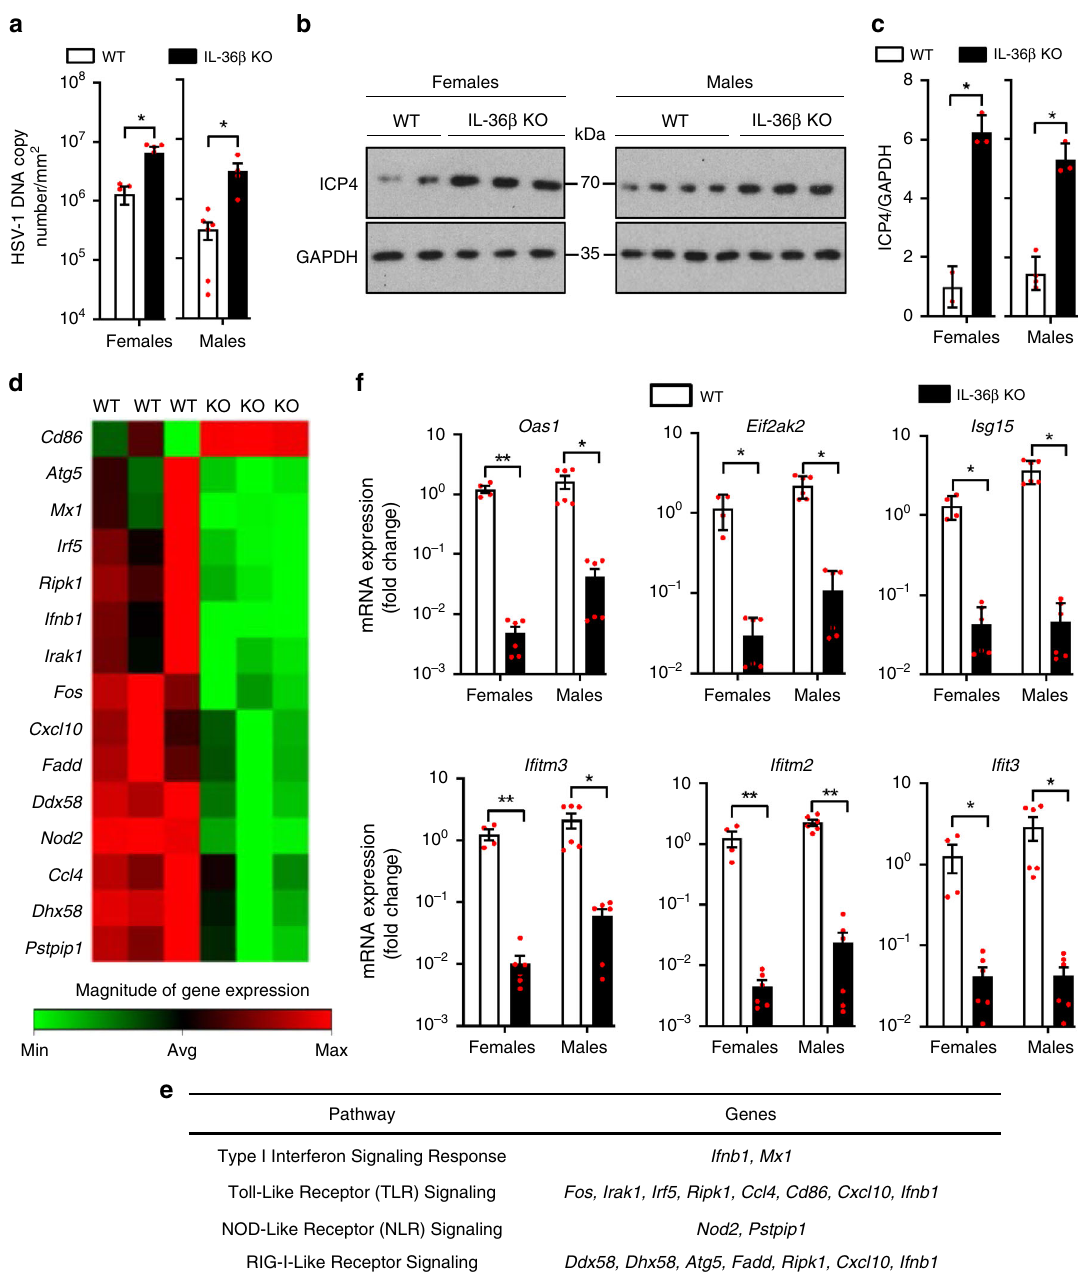
Fig. 1 IL-36 β KO mice exhibit altered responses to HSV-1 skin infection. a Wild type (WT; n = 5 ♀ and 13 ♂ ) and IL-36 β KO mice ( n = 7 ♀ and 12 ♂ ) were infected with HSV-1 on the fl ank and skin regions along HSV-1 infected dermatomes collected 6 days post-infection. Viral DNA loads were determined by QPCR. Data are pooled from three independent experiments and shown as means ( ± SD). * p < 0.05 (One-Way ANOVA). b , c Viral ICP4 protein levels were examined by Western blotting ( b ) and quanti fi ed using ImageJ software ( c ). GAPDH was used as loading control. Data are representative of three independent experiments and shown as means (±SD) in c (WT: n = 2 female and 4 male; IL-36 β KO mice: n = 3 female and 3 male). * p < 0.05 (one-way ANOVA). d Wild type and IL - 36 β KO mice were infected with HSV-1 ( n = 3 per group) on the fl ank and skin RNA isolated 6 days post-infection. Heat-map of genes differentially expressed in the two strains is shown. e Pathway associations of genes identi fi ed as differentially expressed in d . f Expression of Oas1, Eif2ak2, Isg15, I fi tm3, I fi tm2, and I fi t3 mRNAs were examined in wild type and IL-36 β KO HSV-1 infected skin ( a ). The mRNAs were normalized against GAPDH and are shown as relative expression compared to female wild-type mice (means ± SD). * p < 0.05; ** p < 0.005 (one-way ANOVA). Each red dot represents a single data point. Source data are provided as a Source Data fi Fig. 1). Nuclear pSTAT1 staining was observed distinctively in keratinocytes in the epidermis and hair follicles proximal to HSV-1 lesions (Supplementary Fig. 1i, j). Some immune cells under the wound scabs, in the dermis and subcutaneous fat were also positive